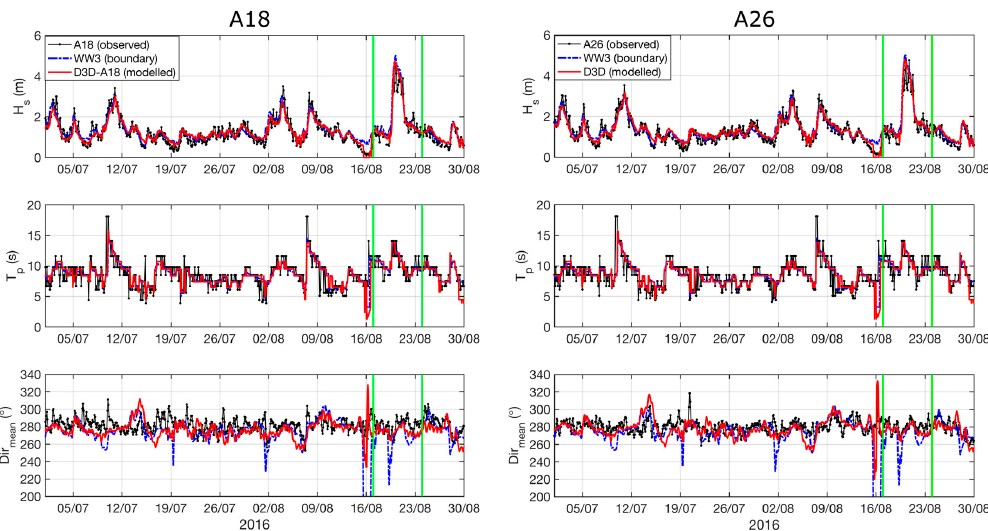
Figure 3. Wave observations at acoustic Doppler current profilers (ADCPs) A18 ( left column) and A26 ( right column) with Delft3D model output at each location, for the July–August 2016 validation period. WW3 offshore boundary conditions are also indicated. Observed wave direction has a 5-point moving average filter applied. The green vertical lines indicate the 1-week calibration period, including the peak wave event. The wave height is obtained from the Roller model; period and direction are from the WAVE (simulating waves nearshore (SWAN)) model.